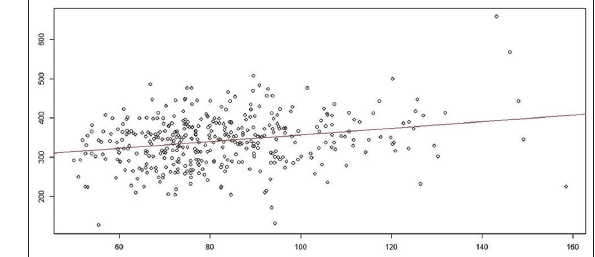
FIGURE 4. Regression line showing the tendency of the linear regression results of the phase angle (Y-axis) unit is in degrees and the maximum hand grip strength (X-axis) unit is in Newton.